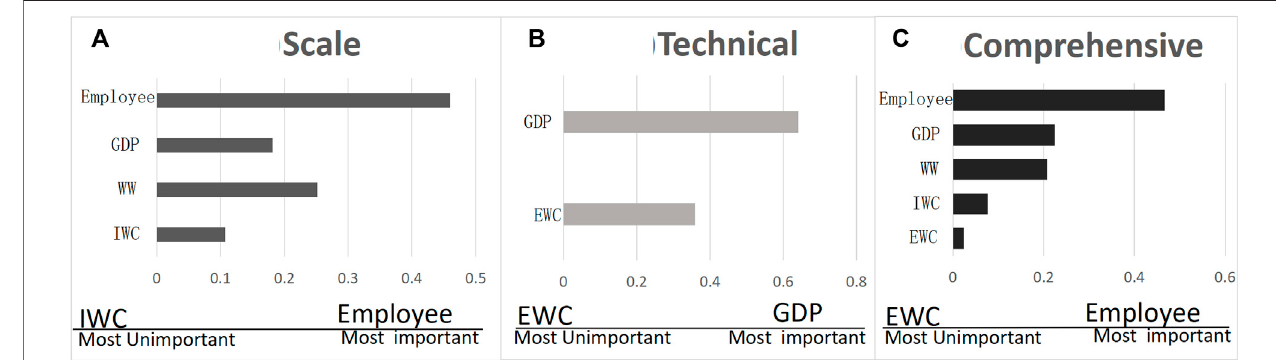
FIGURE 8 | Signi fi cance of each